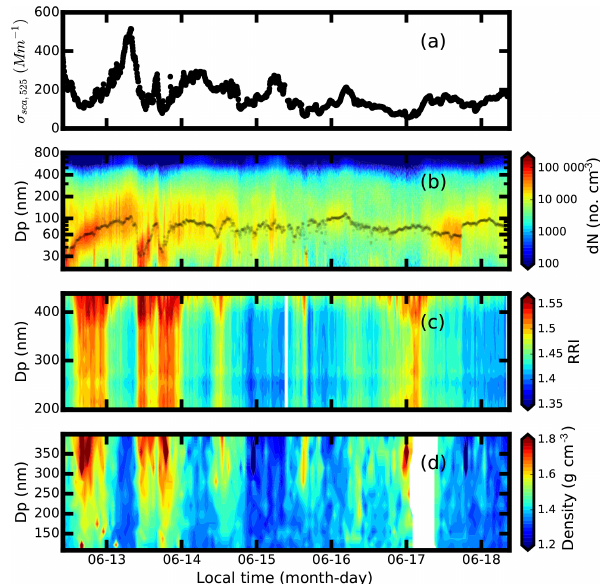
Figure 5. Time series of measured (a) scattering coefficient at 525nm, (b) PNSD, (c) size-resolved RRI, (d) size-resolved effec- tive